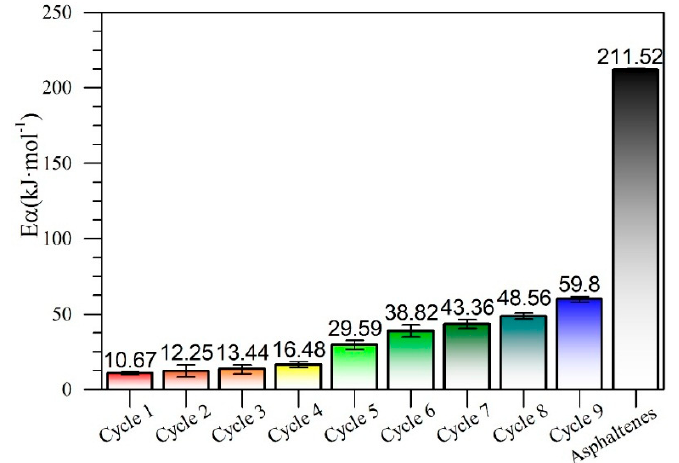
Figure 6. Arrhenius plot for the isothermal model of decomposition-gasification of n -C 7 asphaltenes in the presence and absence of nanoparticles CeNi0.89Pd1.1 through regeneration cycles of adsorption and subsequent catalytic steam gasification.